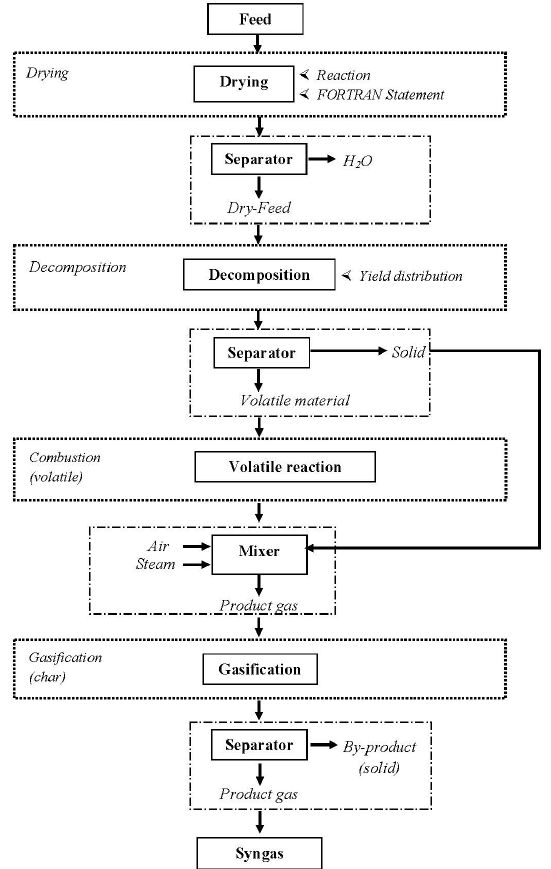
Figure 3. Process flowchart of fluidized bed